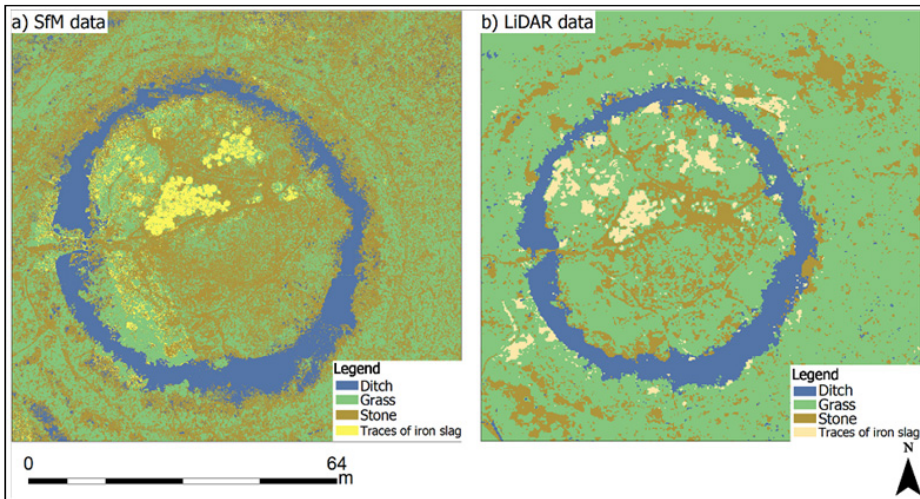
Figure 7. The classification maps produced using the Support Vector Machine (SVM) algorithm based on RGB datasets obtained from: ( a ) SfM data and ( b ) LiDAR data.